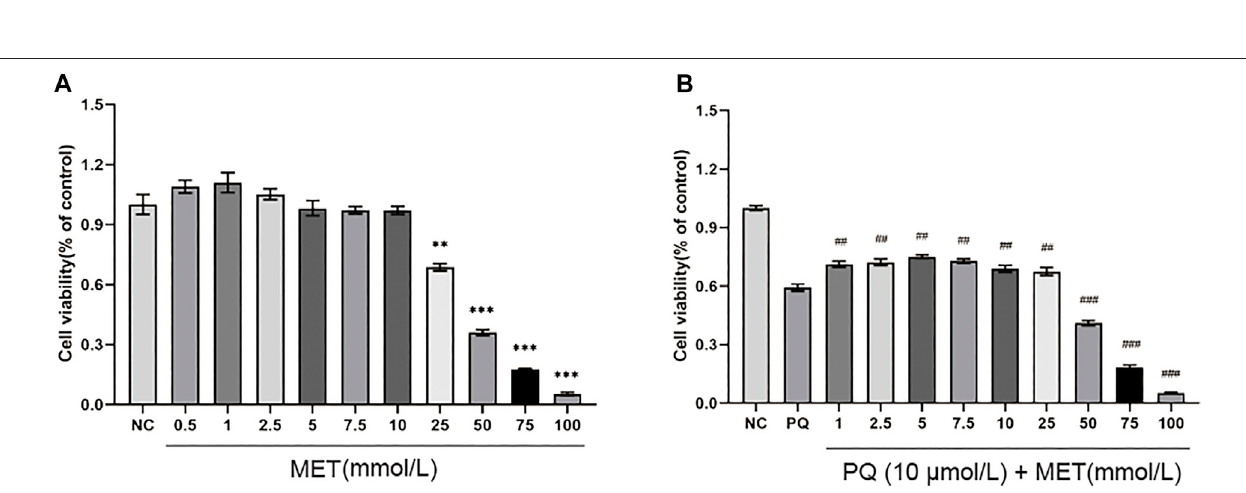
Frontiers in Pharmacology |